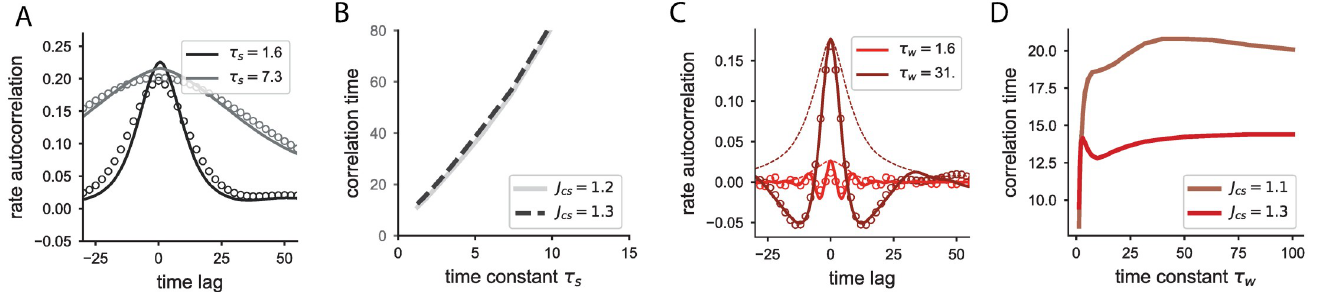
Fig 5. Autocorrelation function and timescale of the network activity in the fluctuating regime. A: Autocorrelation function of the firing rates in the network with synaptic filtering; dynamical mean field results (solid lines) with their corresponding envelopes (dashed lines), and results from simulations (empty dots). p ffiffiffiffiffiffiffiffiffiffiffiffiffiffiffiffiffiffiffiffi ¼ 1 : 2 . B: Effective timescale of the network activity as a function of the synaptic time constant for the network with Connectivity strength J ¼ J þ g 2 C C cs E I synaptic filtering. The network coupling does not have a strong effect on the effective timescale. C: Autocorrelation function of the firing rates, as in A, for the system with adaptive neurons. J = 1.3. D: Effective timescale of the firing rates, as in B, for the system with adaptive currents. cs